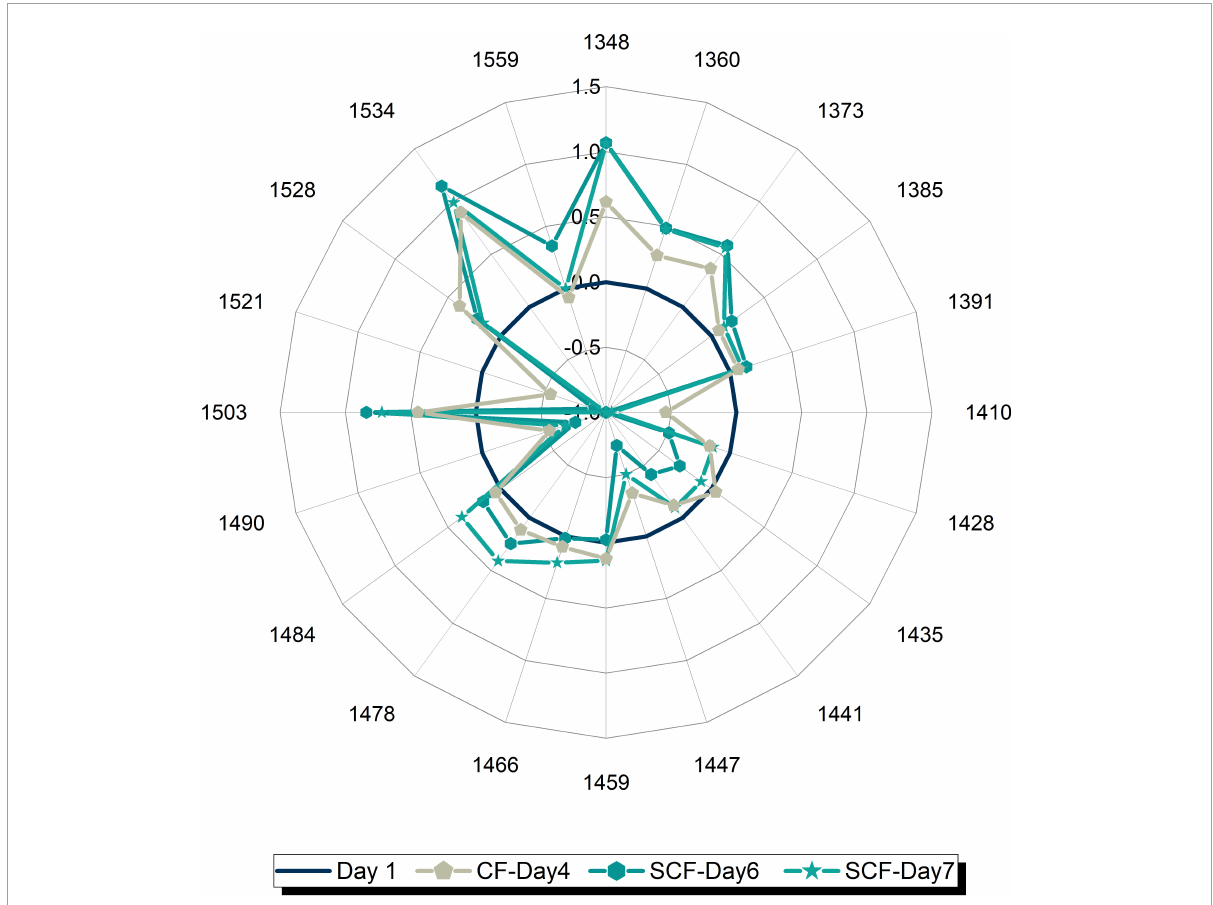
FIGURE9 Comparison of water spectral patterns of strawberries in the control fridge (CF) on day 4 and strawberries in supercooling fridge (SCF) on days 6 and 7 shows that the presence of electric field delays the ripening in cold